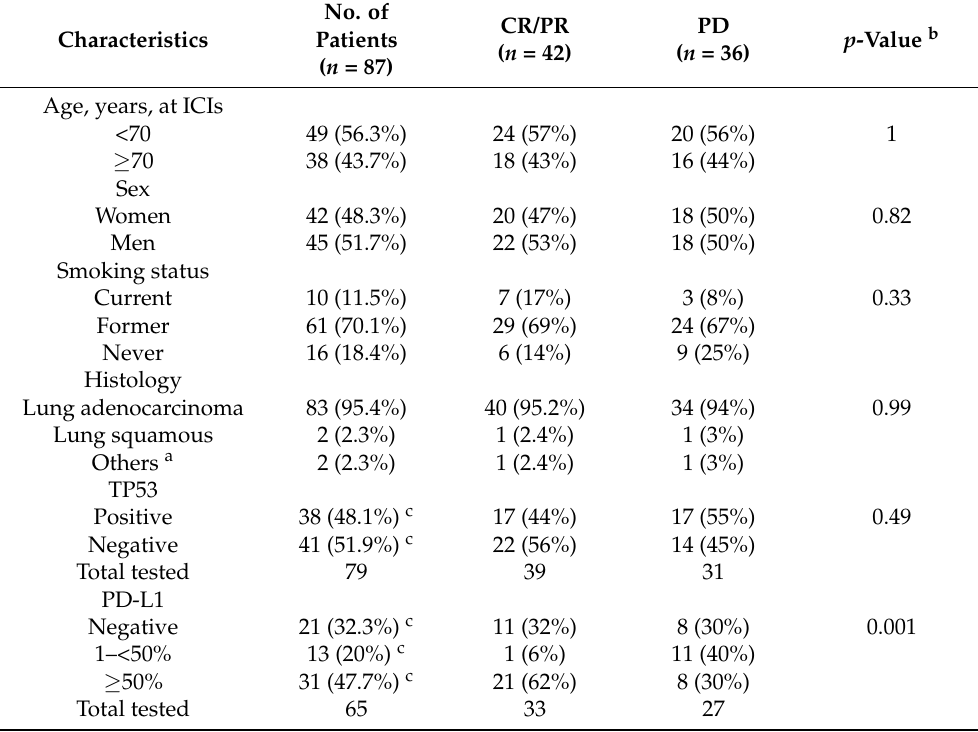
Table 1. Baseline patient characteristics ( n =